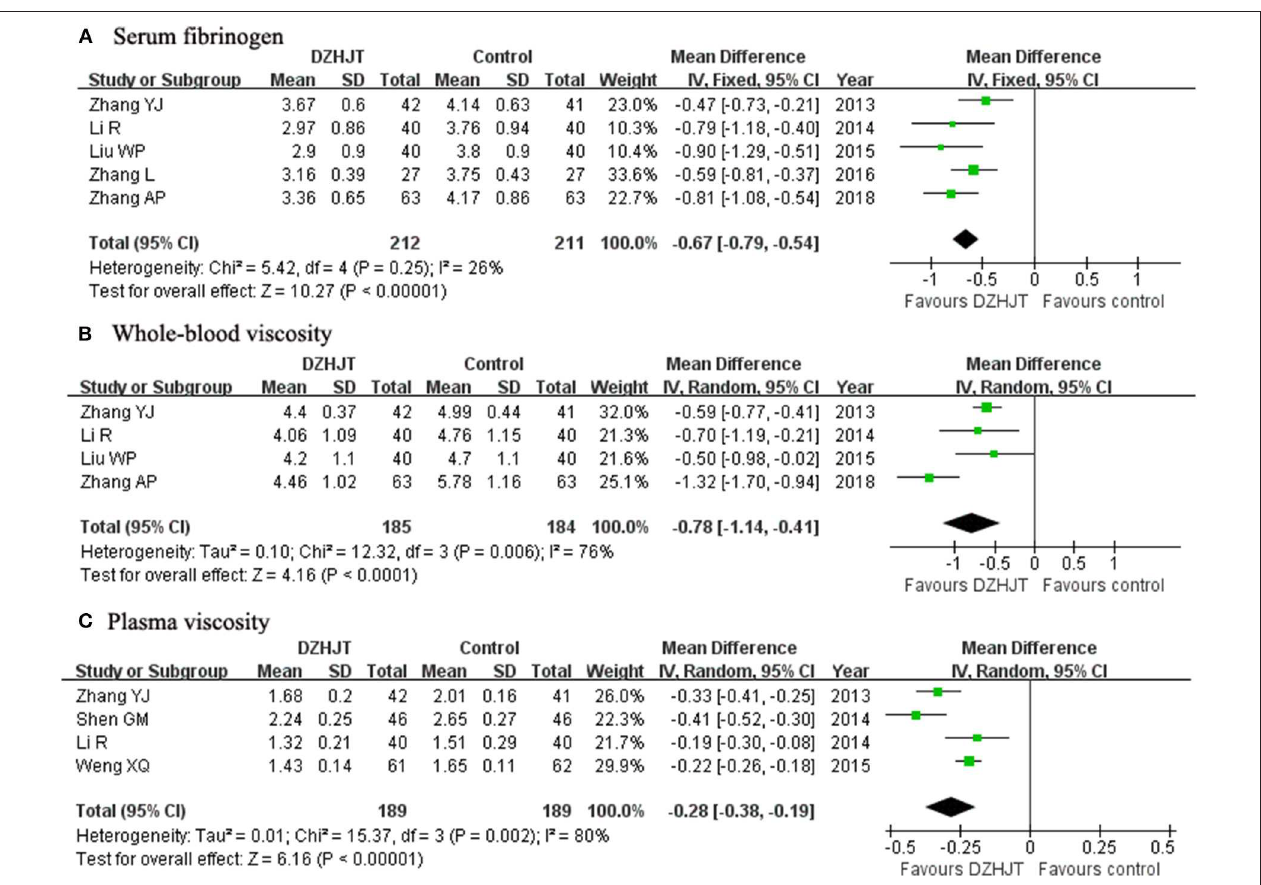
FIGURE 4 | Forest plots showing comparison of the serum fibrinogen (A) , whole-blood viscosity (B) , and plasma viscosity (C) in patients with or without DZHJT treatment.